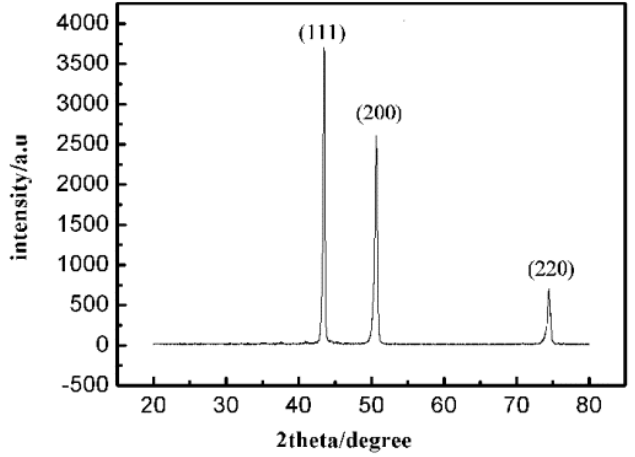
Figure 4. X-ray di ff raction (XRD) result of the XZ section of the Figure 4. X-ray diffraction (XRD) result of the XZ section of the sample.